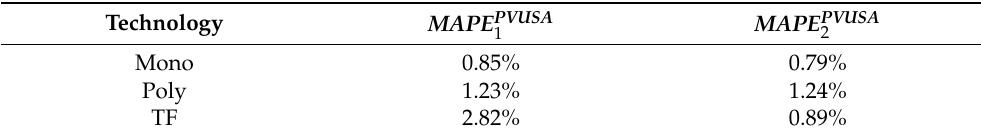
Table 9. MAPE for monocrystalline, polycrystalline, and thin-films modules, under PVUSA